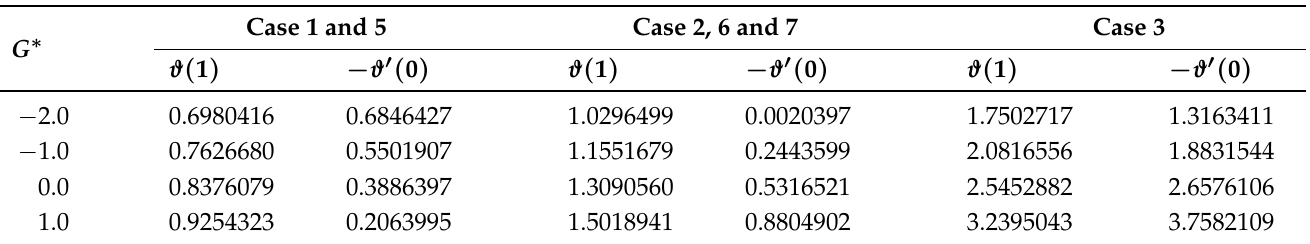
Table 9. Variation of temperature distribution ϑ ( η ) with heat generation/absorption parameter G ∗ at S =4 and Pr